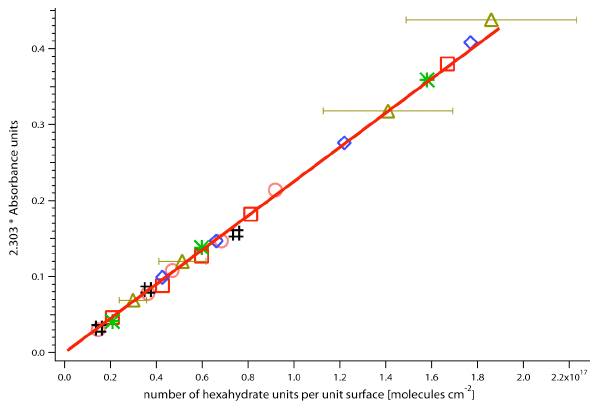
Fig. 3. Plot of the IR absorbance at 3426cm − 1 as a function of Figure 3. Plot of the IR absorbance at 3426 cm -1 as a function of the number of formula units per unit the number of formula units per unit surface for pure HCl hexahy- q surface for pure HCl hexahydrate (HCl•6H 2 O). The different symbols represent the six different drate (HCl 6H 2 O). The different symbols represent the six differ- samples listed in Table 3. From the fit one obtains a cross section of σ = (2.3 ± 0.7) 10 -18 cm 2 /molec ent samples listed in Table 3. From the fit one obtains a cross sec- per HCl hexahydrate formula unit. tion of σ = (2.3 ± 0.7) 10 − 18 cm 2 molec − 1 per HCl hexahydrate formula